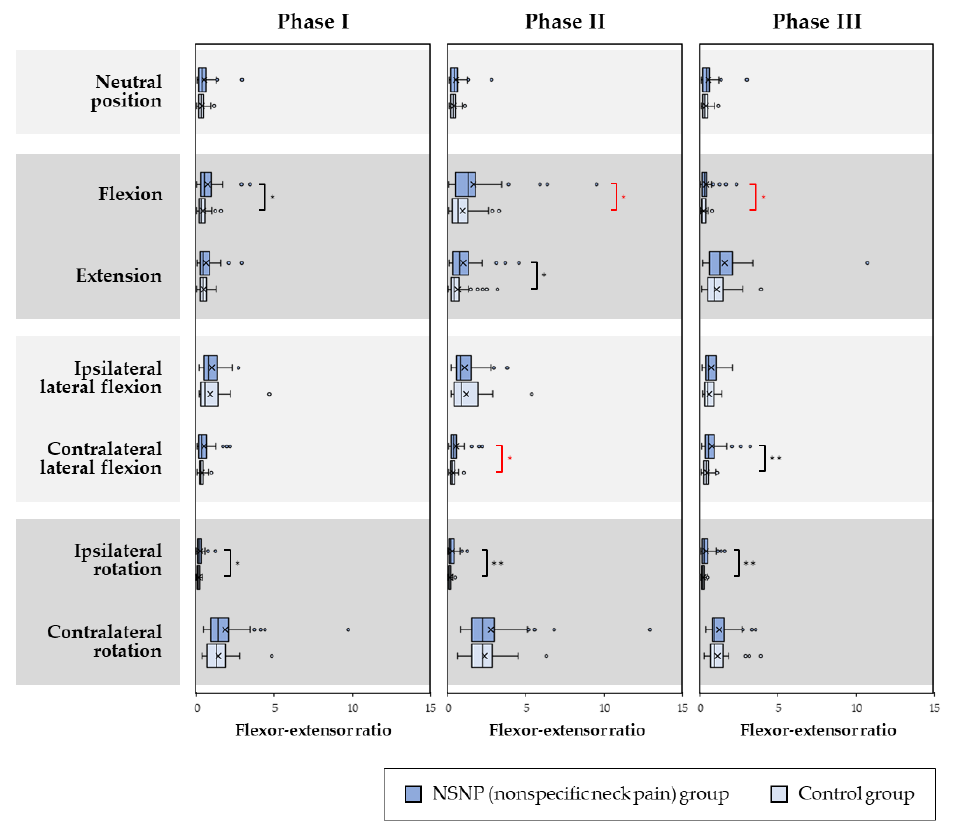
Figure 3. Flexor – extensor ratio in each phase in the NSNP and control groups. The ratios in Phase I in extension, Phase I in ipsilateral rotation. and Phase I and II in contralateral rotation in the control group were normally distributed but not for the remaining phases. Red asterisks indicate a significant difference in only parametric analysis, and black asterisks indicate a significant difference in both analyses. The top, middle, and bottom lines of the boxes correspond to the 75th, median, and 25th percentile, respectively. The whiskers extend from the minimum to the maximum. The cross marks indicate the arithmetic means. The powers were less than 0.8 in 15 phases (neutral position, extension, ipsilateral lateral flexion, and contralateral rotation in phase I, II, and III; flexion in phase II and III; contralateral lateral flexion in phase I). The rest of the six phases were β ≥ 0.8. * indicates p < 0.05 and ** indicates p < 0.01.